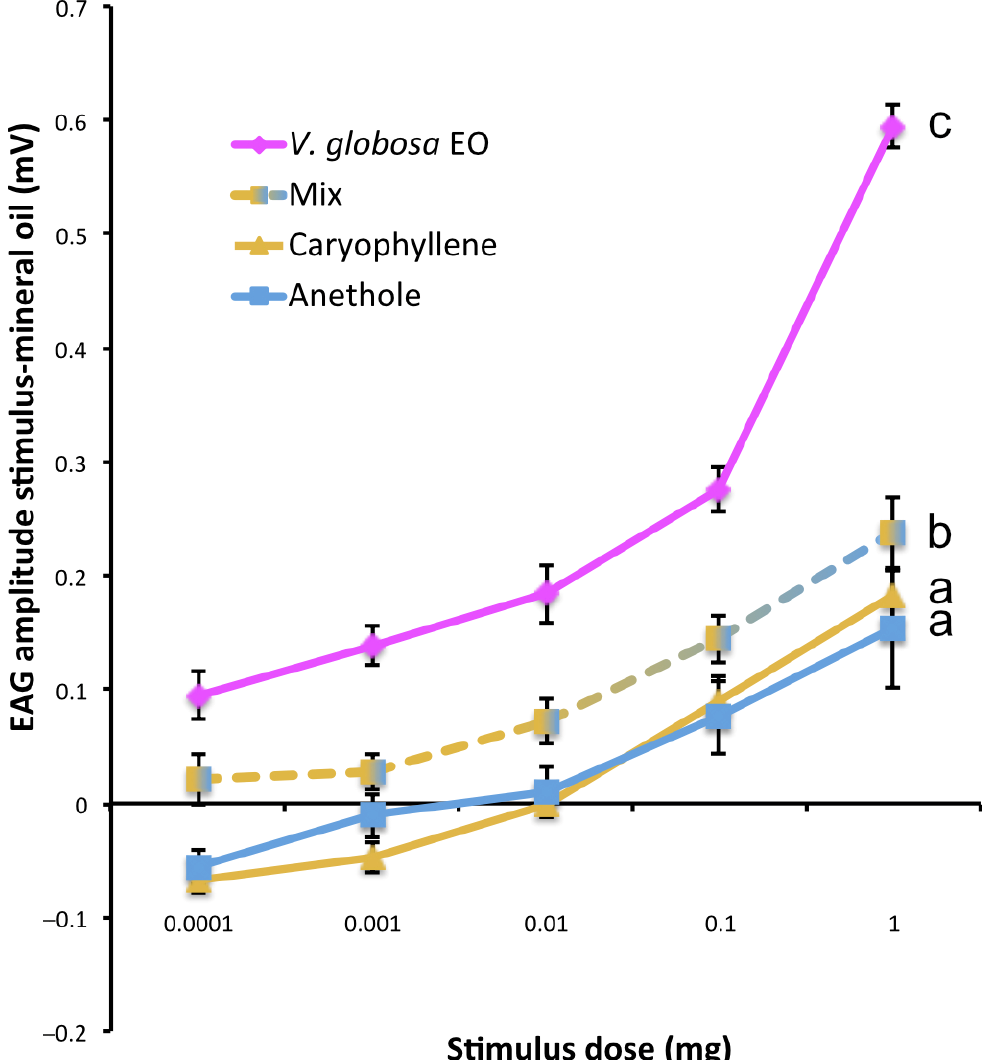
Figure 4. Dose-response curves of EAG responses to the essential oil (EO), individual constituents and their mixture (Mix). Responses to the solvent mineral oil were subtracted (means and SE). Dose-response curves with different letters are significantly different (ANOVA followed by Tukey’s post hoc test p < 0.0001). n = 17 for anethole, caryophyllene and mix, n = 11 for V. globosa EO.